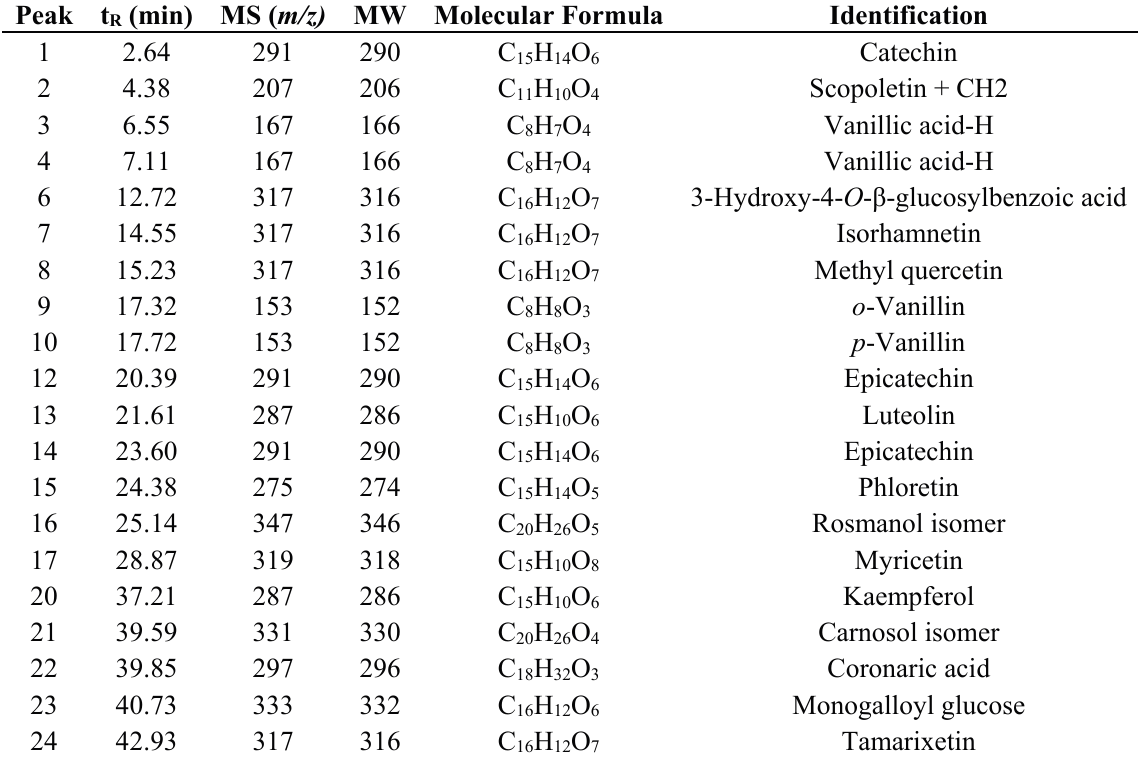
Table 4. Identification of purified PPP by UPLC-MS. Mass spectral data positive mode. Peak Molecular